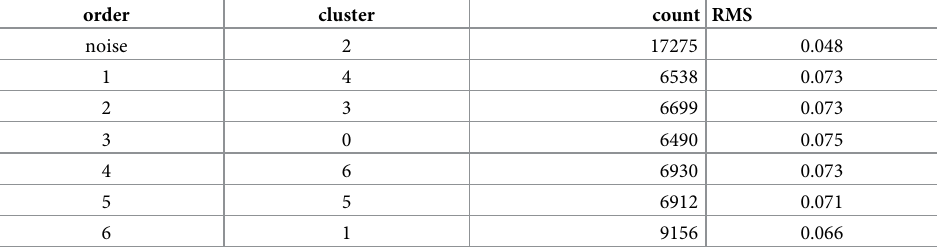
Table 3. Data of the different